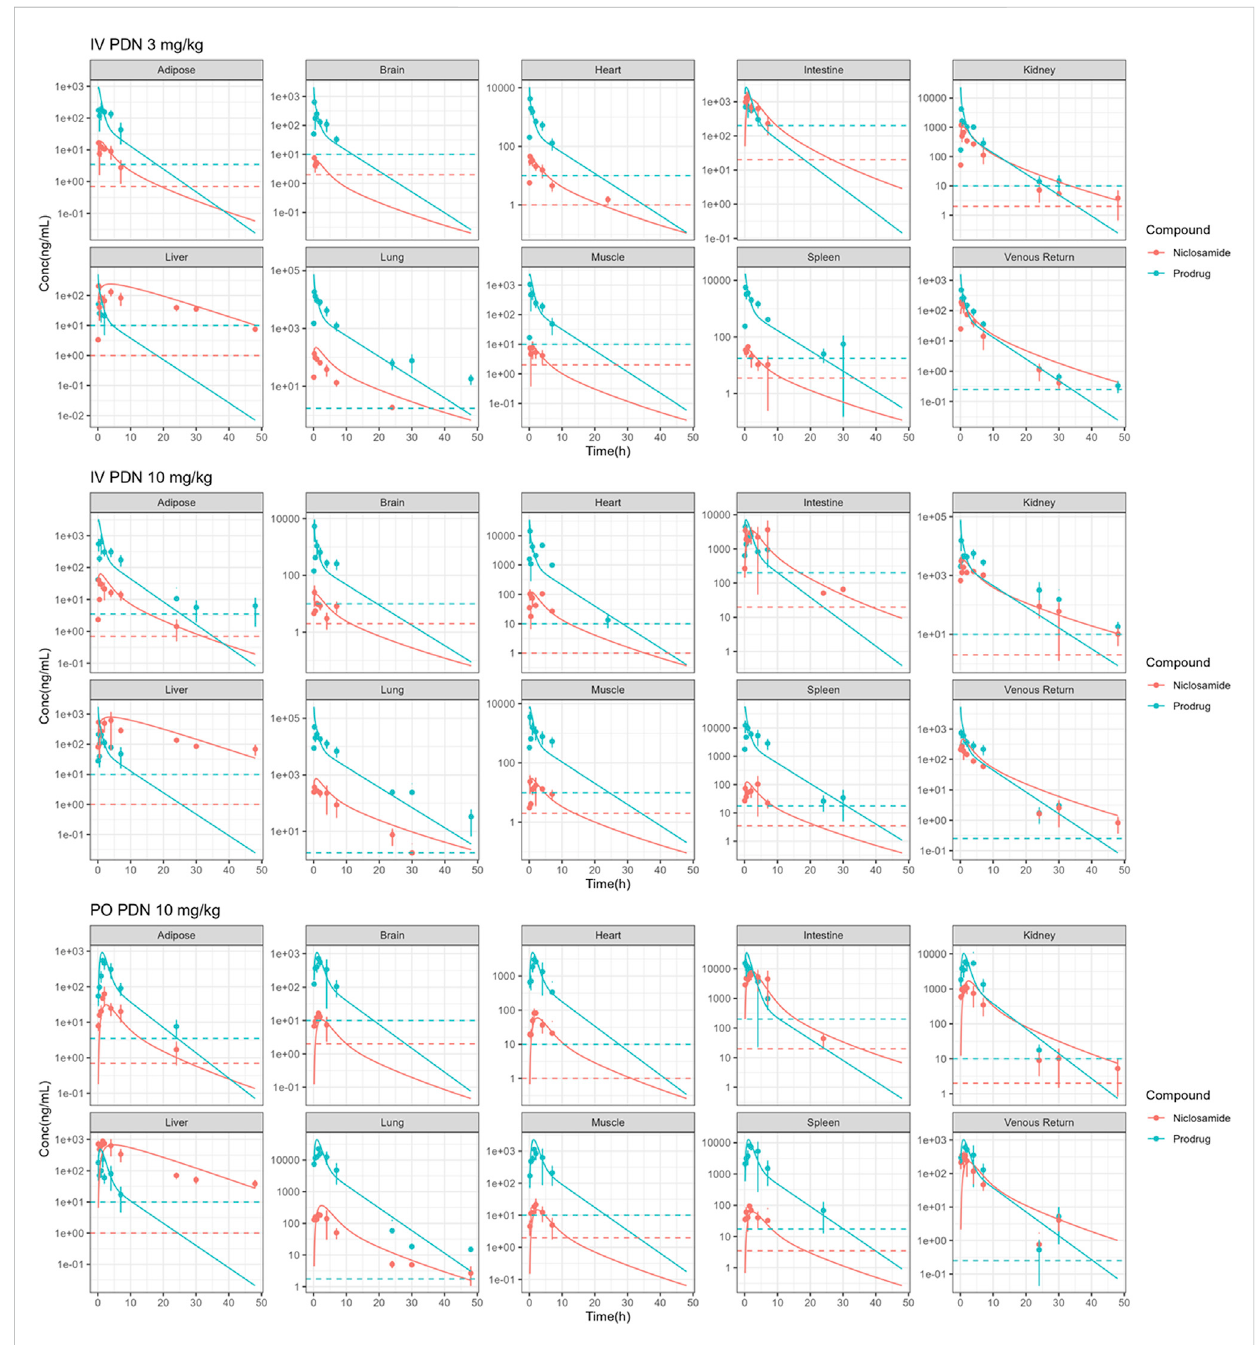
FIGURE 3 Observed (points) and simulated (solid lines) concentrations of Nc and PDN in plasma, liver, lung, brain, fat, small intestine, heart, kidney, muscle, spleenfollowingIVadministration of3and10 mg/kgPDN, andPOadministrationof10 mg/kgPDNinmice.(Dottedlines:lowestlimitsofquanti fi cation).